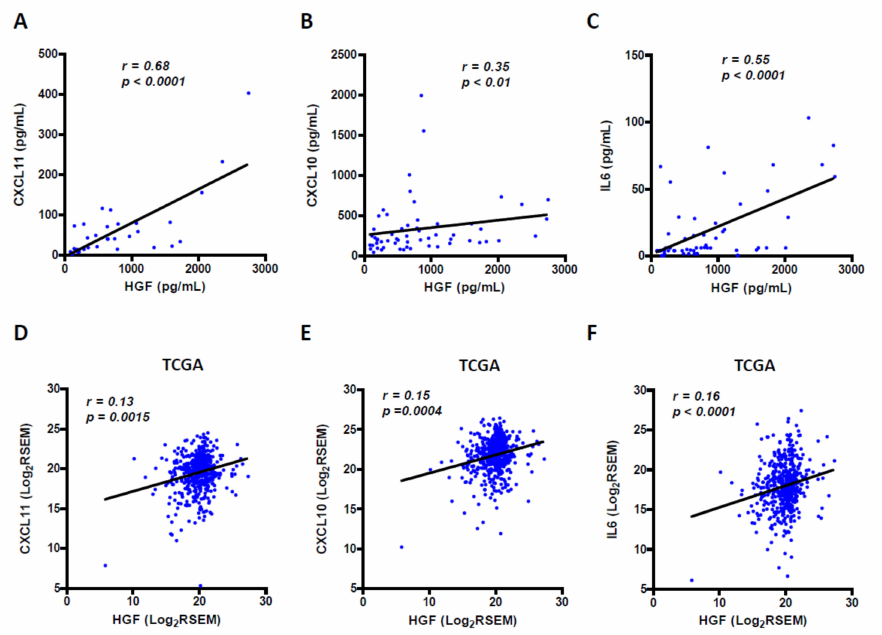
Figure 6. Correlation analysis between HGF levels and amount of CXCL11, CXCL10 and IL6. In our cohort of patients, a very significant positive correlation is observed between blood HGF and CXCL11 ( p < 0.0001) ( A ), CXCL10 ( p < 0.01) ( B ) and IL-6 ( p < 0.0001) ( C ). Using public data from TCGA, mRNA levels of HGF are also significantly correlated with those of CXCL11 ( p = 0.0015) ( D ), CXCL10 ( p = 0.0004) ( E ) and IL-6 ( p = 0.0001) ( F ). Correlation was determined using Spearman’s rank correlation